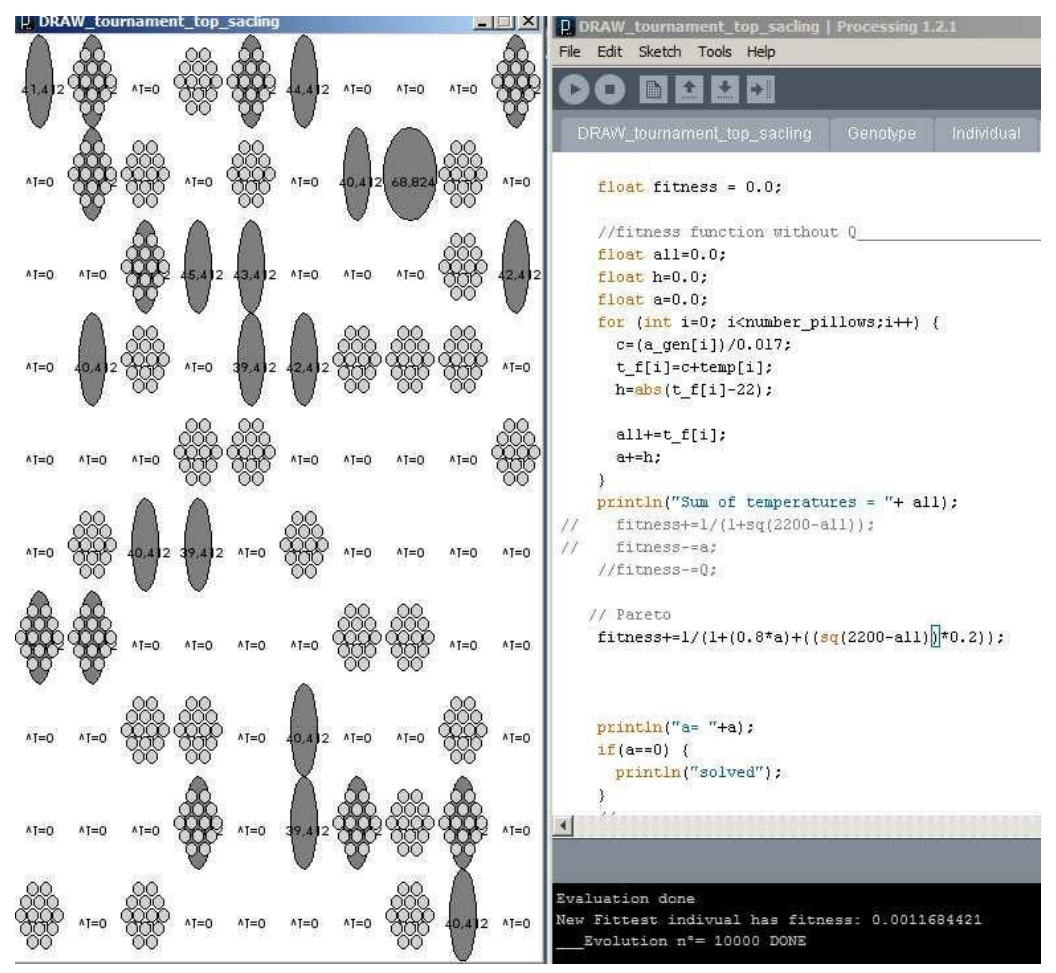
Figure 14. Results for the 10,000th generation of the membrane performance.